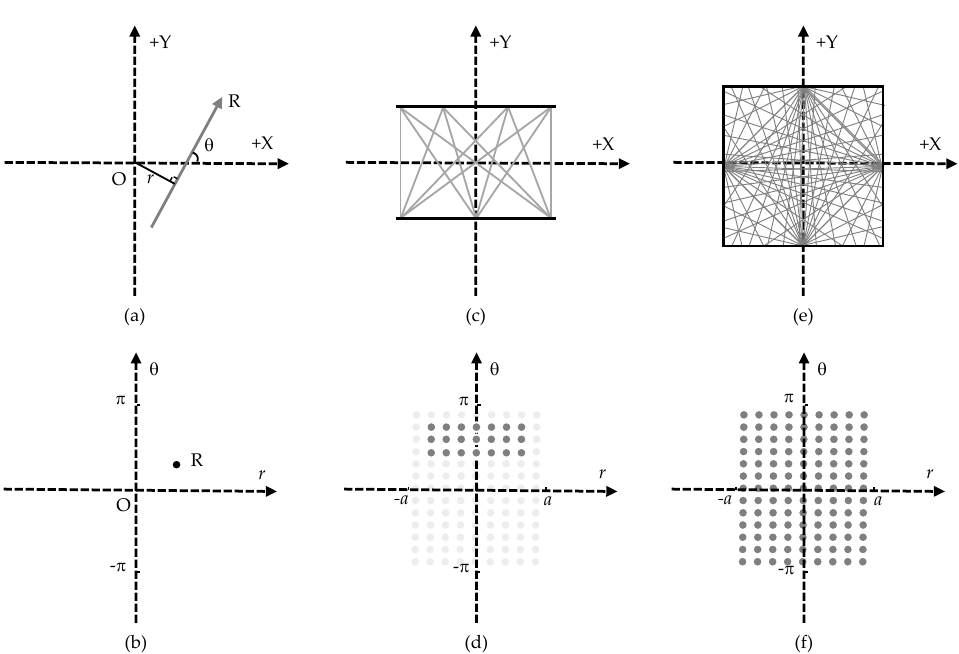
Figure 6. The distributions of light ray in two different coordinate systems. ( a ) a single ray in CCS, ( b ) a single ray in PCS, ( c ) 2PP light field in CCS, ( d ) 2PP light field in PCS, ( e ) the cube surface light field in CCS, ( f ) the cube surface light field in